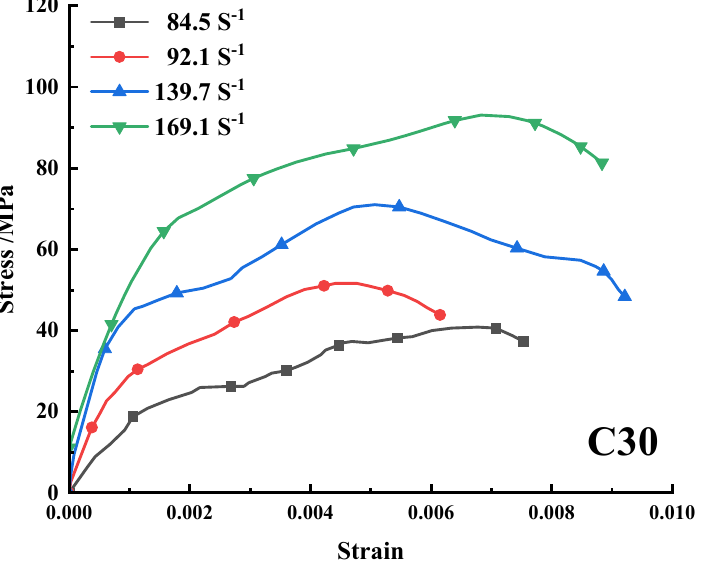
Figure 8. Stress-strain curves for HPC (C30) under various loading rates at a high temperature of 300 °C.